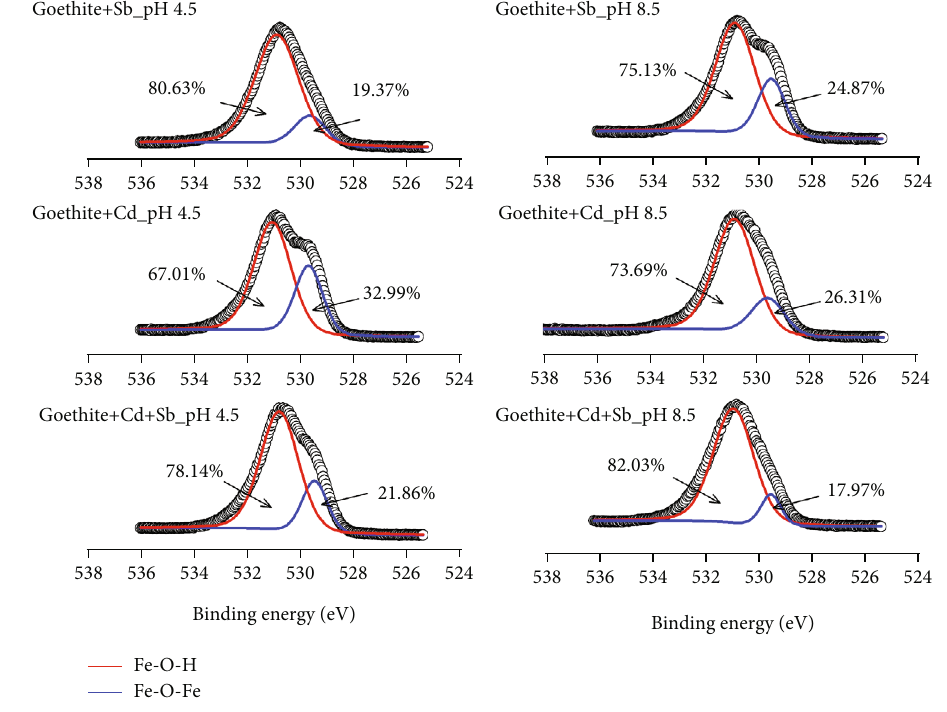
Figure 5: High-resolution O 1s XPS spectra of goethite after the sorption of Cd(II) and/or